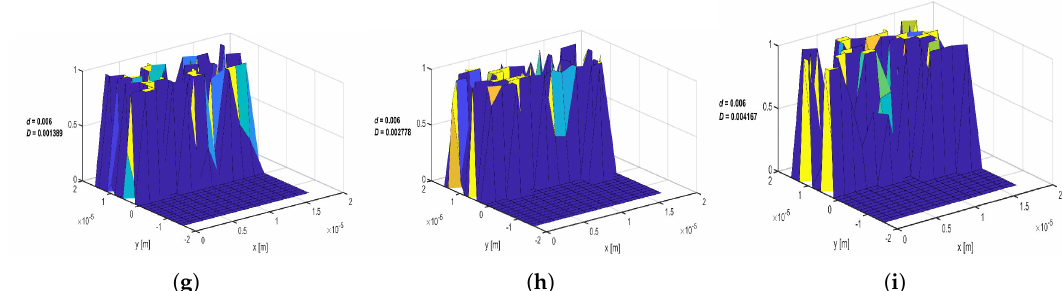
Figure A4. Concentration distribution within the porous media with variable linear drift ratio and dispersion coefficients correspond to ( a ) d = 0.2, D=0.001389 ( b ) d = 0.2, D = 0.002778 ( c ) d = 0.2, D = 0.004167 ( d ) d = 0.03, D = 0.001389 ( e ) d = 0.03, D=0.002778 ( f ) d = 0.03, D = 0.004167 ( g ) d = 0.06, D = 0.001389 ( h ) d = 0.06, D = 0.002778 ( i ) d = 0.06, D = 0.004167 at a period of 50 days.